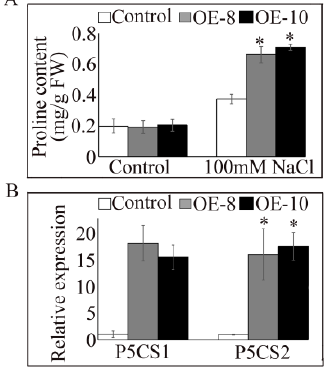
Figure 7. Levels of proline in PtrDHN-3 -overexpressing Arabidopsis plants. Wild-type (WT) and overexpressing plants were grown in 1/2 MS medium with or without 100 mM NaCl for 48 h and then analyzed. ( A ) Proline contents ( B ) expression of proline biosynthesis-related genes under salt stress. Asterisks indicate a significant difference compared to the control plants at p < 0.05.